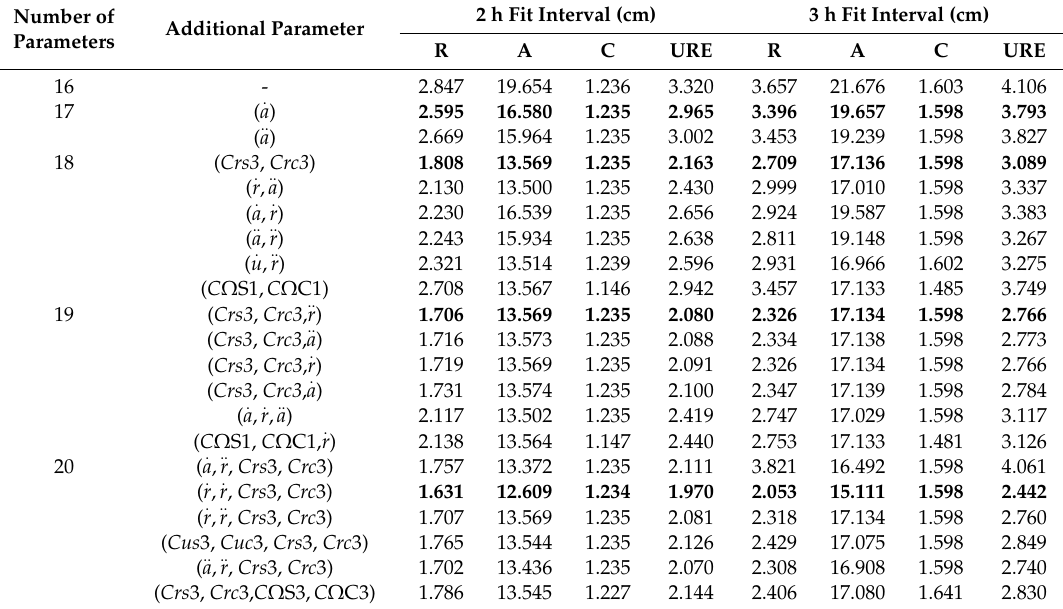
Table 5 lists the RMS of RTN components and the URE for PRN: C02 (or BeiDou-GEO6). Compared to the set of 16 compulsory parameters, the first-rate ( semimajor axis a ff ected the fit accuracy in the radial and along-track but not cross-track directions. In the case of adding two optional parameters, unlike the fit results of IGSO in Table 4, the first-rate and second-rate terms of the semimajor axis and radius predominantly influenced the fit accuracy on radial and along-track directions. The optimal parameters turned out to be ( Crs3 , Crc3 ). In the cases of adding three and four optional parameters, the minimum fit errors were achieved by adding ( Crs3 , Crc3 , . . a , r , Crs3 , Crc3 ), respectively. Similar to the fit results of IGSO, the fit errors in the cross-track direction ( were still dependent on harmonic correction terms of RAAN, such as ( C Ω S1, C Ω C1), ( C Ω S1, C Ω C1, and (Crs3, Crc3, C Ω S3, C Ω C3). The correction terms for inclination and mean motions still had